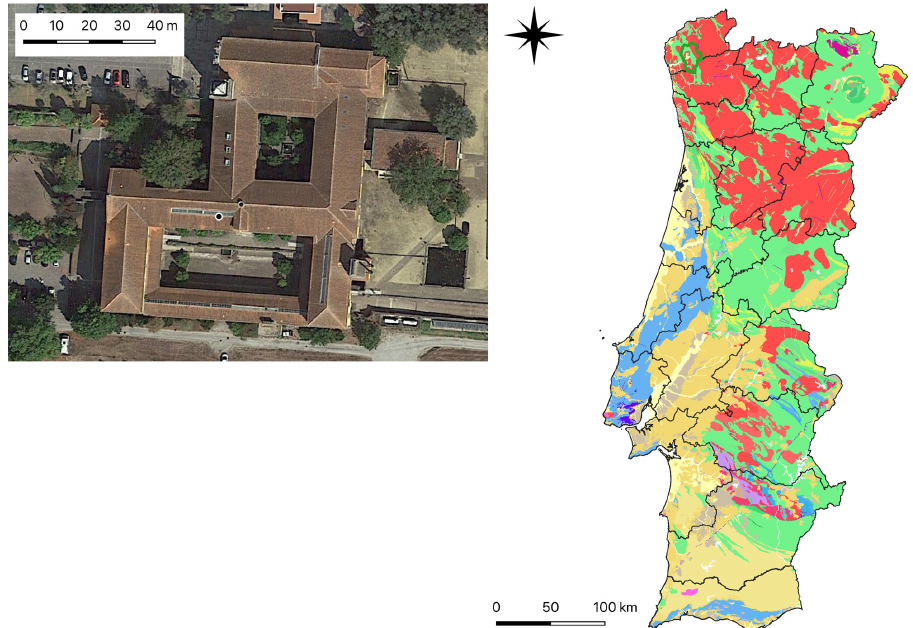
Figure 1. Location of the ESA IPVC academic building. The green circle shows the location of the municipality of Ponte de Lima. The simplified geological representation of Portugal shows the distribution of the granitic rocks (red) and the associated metamorphic rocks (light green) usually associated with high indoor Rn potential. The black dot in the main building highlights the position of the room where the indoor Rn concentration measurements were taken.